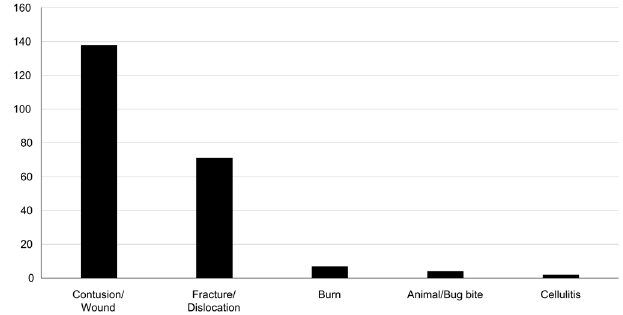
Figure 6. Diagnoses in the Trauma Subgroup.